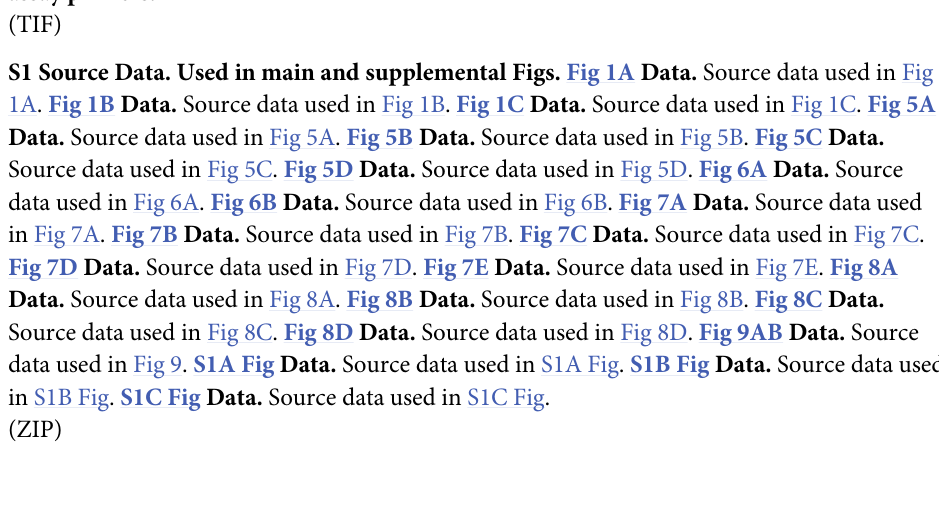
S1 Table. Histology scoring criteria. S2 Table. Primer sequence for QUILLS assays used in this study. S1 Fig. sgRNA levels in hamsters after intranasal inoculation with a 1:1 or 9:1 mixed inocu- lum of B.1 (614G) and B.1.427; and sgRNA levels in hamsters inoculated with a mixed